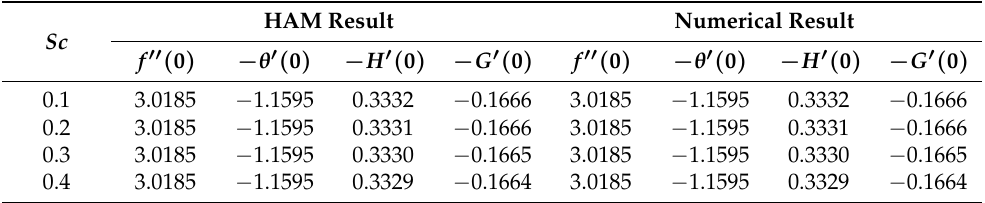
Table 10. Computational for f (cid:48)(cid:48) ( 0 ) , − θ (cid:48) ( 0 ) , − H (cid:48) ( 0 ) and − G (cid:48) ( 0 ) with S = − 0.5, P r = Ha = R = K 1 = K 2 = 0.5, L = δ = 2, Q = 4 and differing values of Sc .